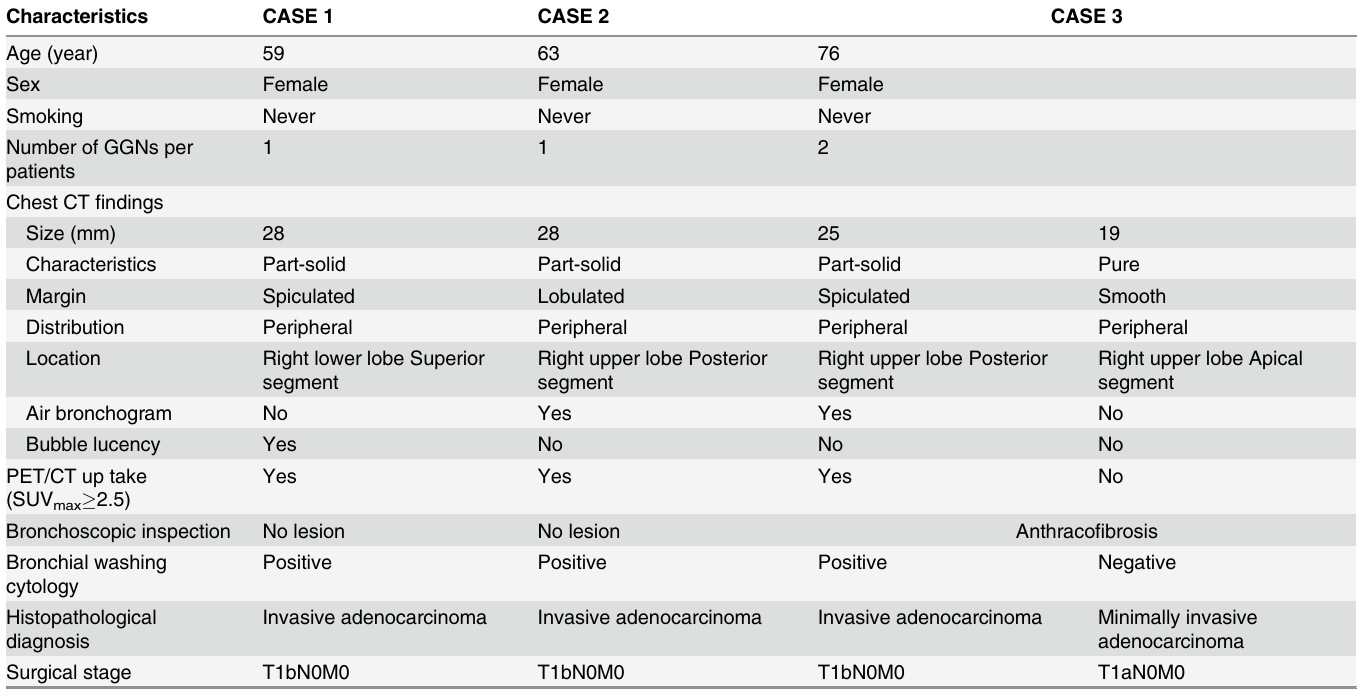
Table 4. Characteristics of patients preoperatively diagnosed with malignancy by preoperative